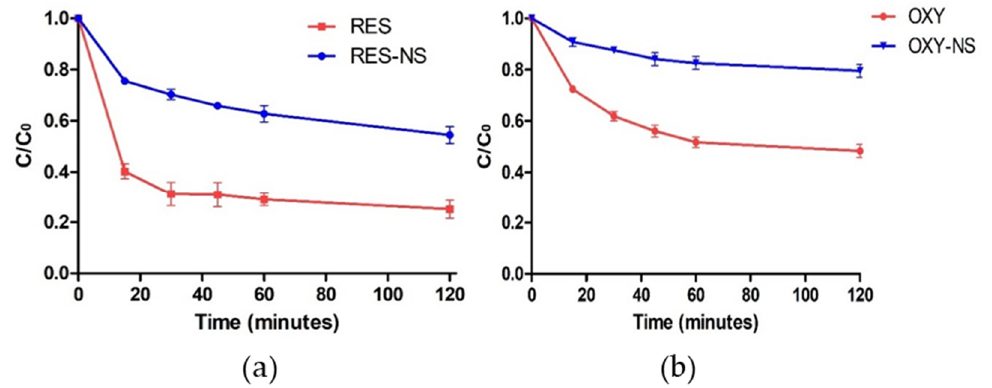
Figure 9. Photodegradation study of ( a ) RES vs. RES-NS and ( b ) OXY vs. OXY-NS.